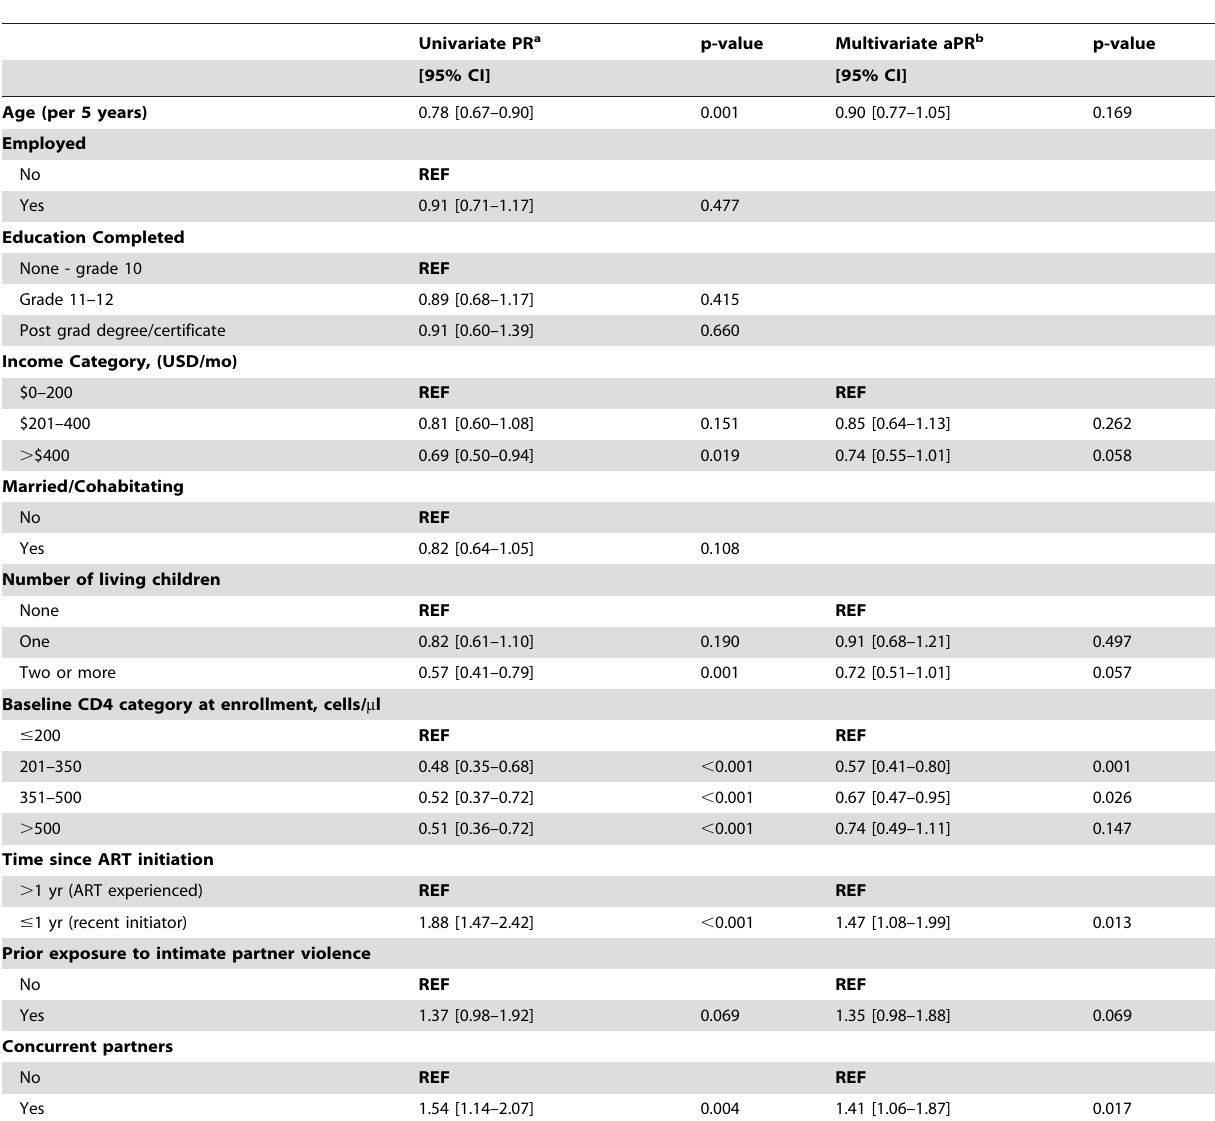
Table 3. Predictors of unmet need for contraception amongst sexually active women not trying to conceive